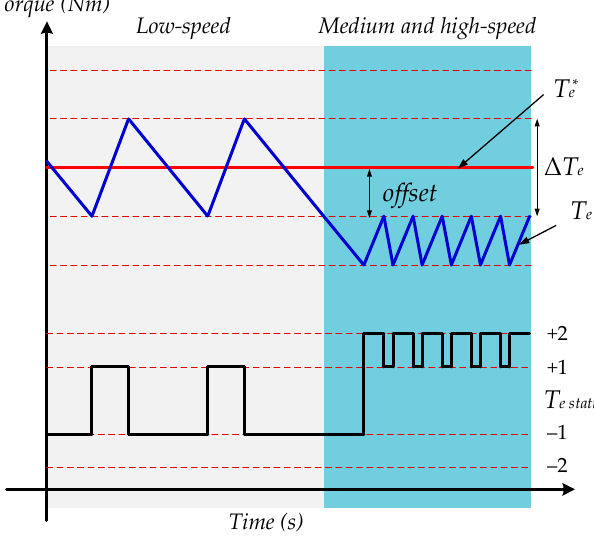
Figure 8. Problem associated with the conventional four-level HTC.